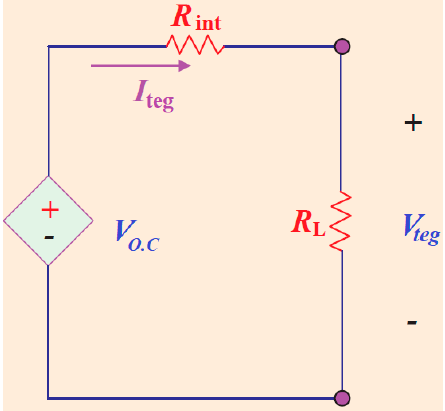
Figure 1. General structure of the TEG. ( a ) general view, and ( b ) circuit. When a temperature difference is occurred across the hot and cold sides, a voltage potential will appear based on the Seebeck effect. The Seebeck effect occurs due to the movement of charge carriers within the semiconductors. Figure 2 presents the equivalent- circuit of the TEG unit. The open circuit voltage as a source ( V O.C ) is series connected with an internal resistance ( R int ) [23,24]. an internal resistance ( R int ) [23,24].